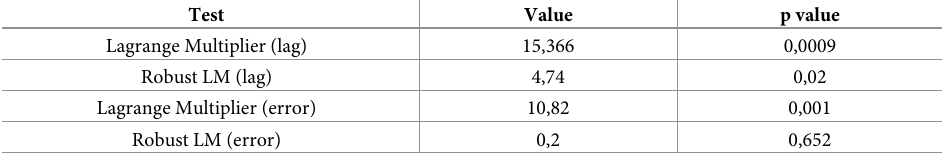
Table 3. Lagrange multiplier test for detect the alternative spatial regression model for the impact of SDH on the AIDS mortality rate in Para´ between 2007 and 2018.